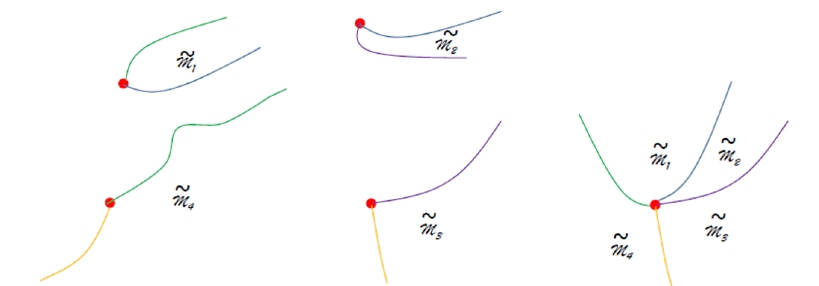
Figure 1 . An example of our cut-and-paste construction, where we cut pieces e M i from four smooth spacetimes (left) and then paste them together cyclicly (right) to form a new spacetime which may include a conical singularity. Each piece e M i is bounded by two hypersurfaces ∂ Σ i ± (colored curves) with common boundary γ i (red dots). The two surfaces ∂ Σ i ± are not allowed to intersect away from γ i . The gluing is then done in a way that identifies all γ i and which cyclicly identifies Σ i + with Σ . In the figure, we have given Σ i + and Σ the same color to make the cut-and-paste ( i +1) − ( i +1) − visually